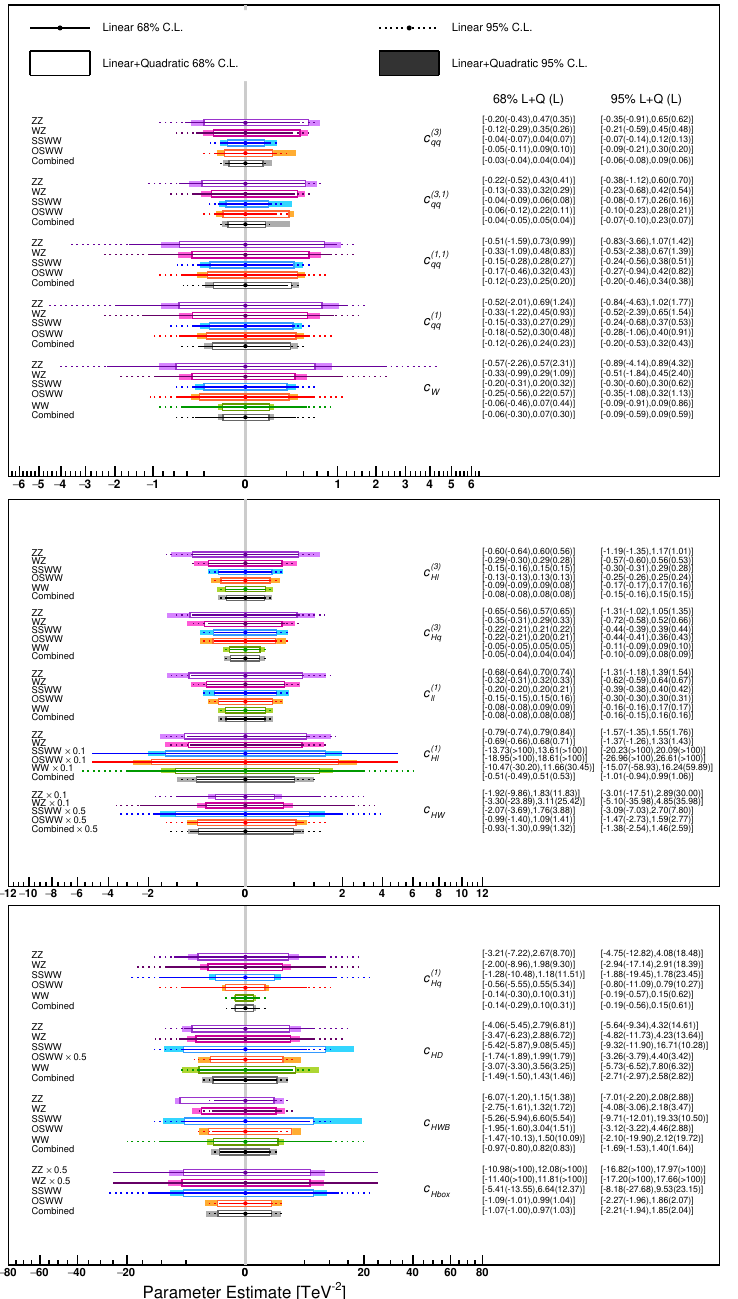
Figure 3 . Individual expected constraints on Wilson coefficients from the leptonic VBS channels ZZ+2j, WZ+2j, SSWW+2j, OSWW+2j and diboson WW. The solid points represent the SM expectation. Solid (dashed) lines indicate the 68% (95%) confidence intervals obtained including only terms linear in the Wilson coefficients in the signal predictions. Open (filled) boxes indicate 68% (95%) confidence intervals obtained including both linear and quadratic EFT